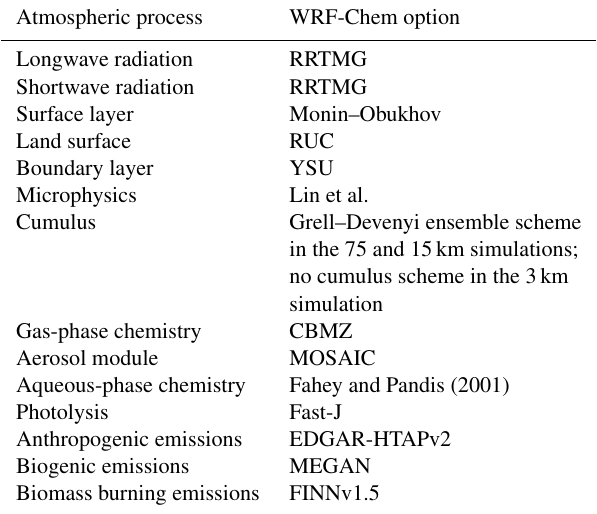
Table 1. WRF-Chem